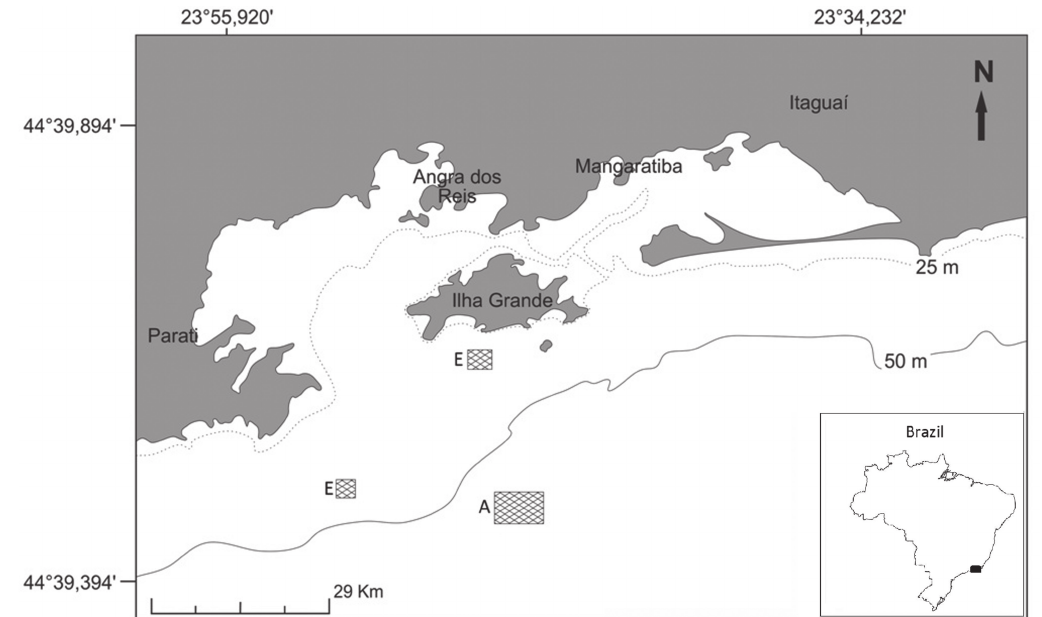
Fig. 1. Location of samples taken between January 2006 and August 2007 on the southern coast of Rio de Janeiro, southeastern Brazil, E = longline; A=